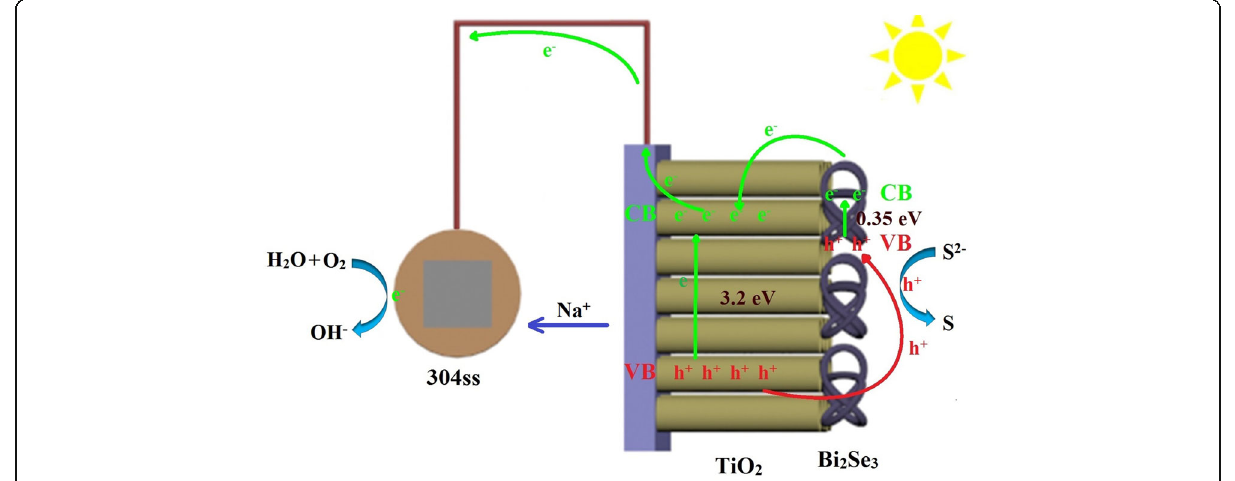
Fig. 7 Schematic representation of the electron transfer processes in Bi 2 Se 3 /TiO